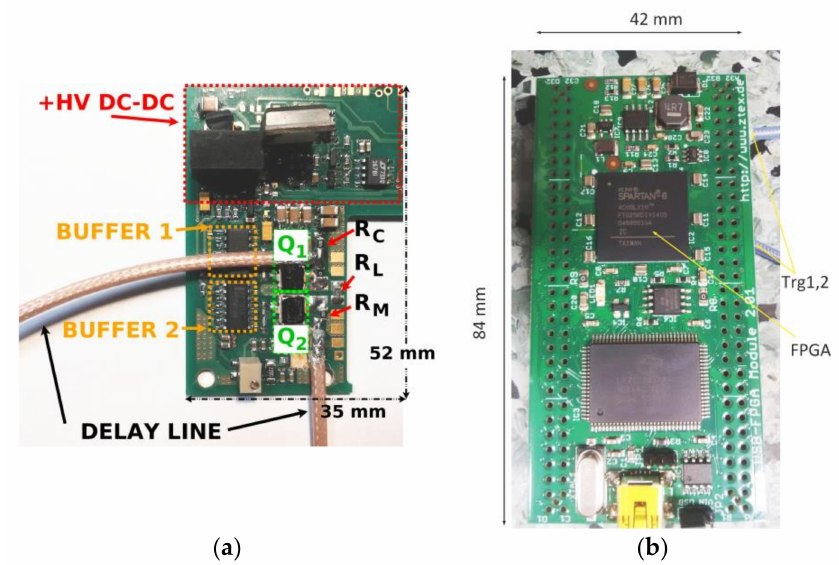
Figure 6. PCBs of the pulsed laser driver system: ( a ) Dual-FET output stage; ( b ) Timing circuit (Field-Programmable Gate Array (FPGA)) PCB–ZTEX evaluation board with the Spartan 6